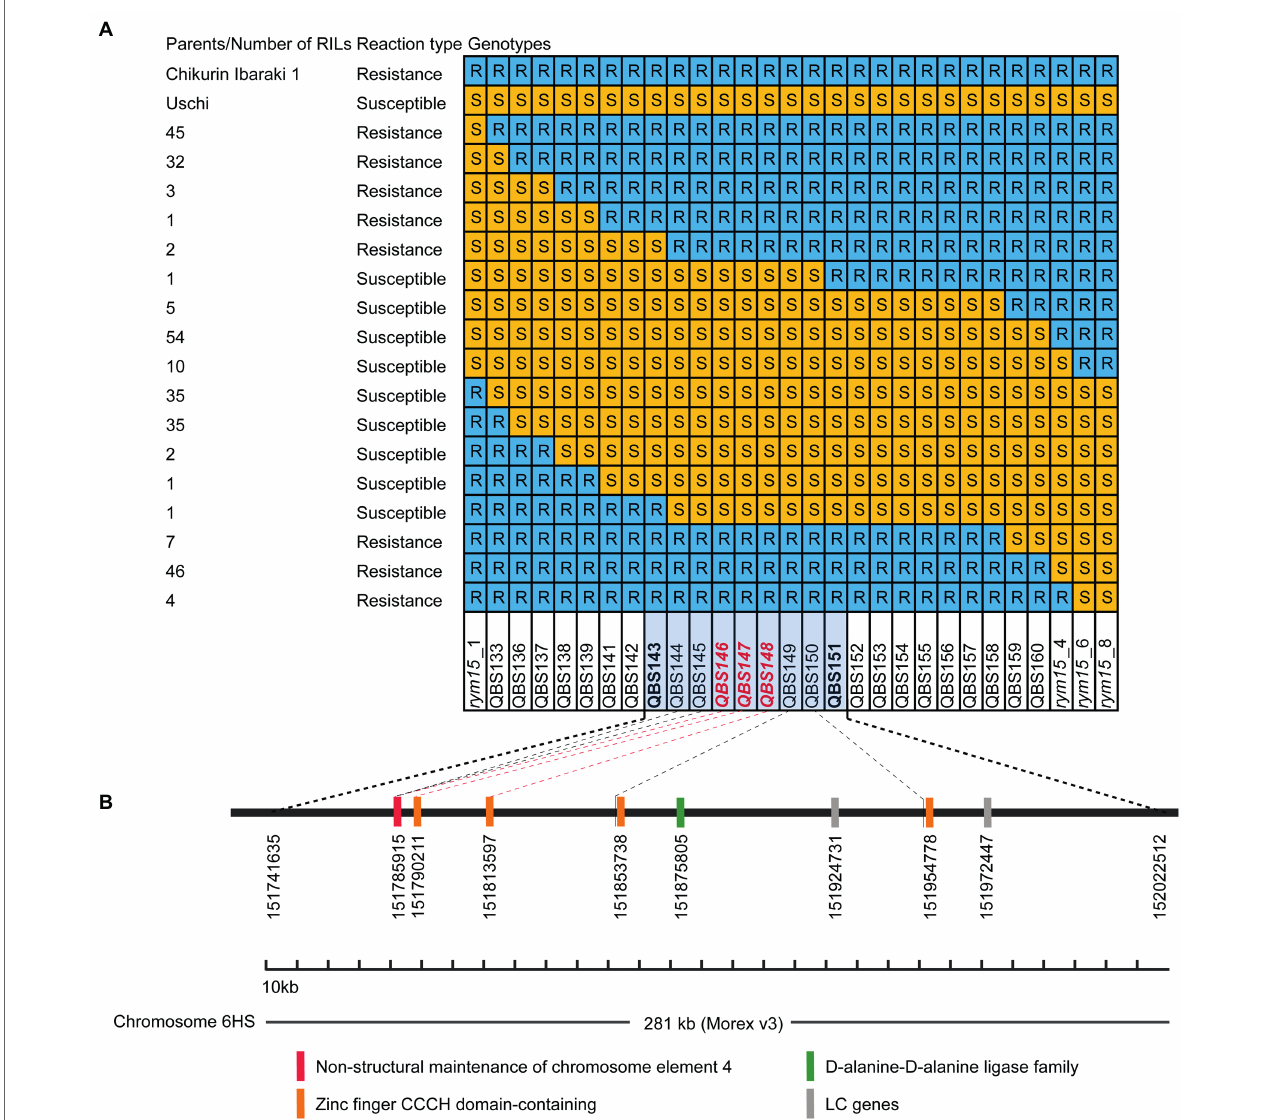
FIGURE 3 | Candidate genes in the rym15 target region of 281 kb. (A) Graphical genotypes of 284 F 4 RILs derived from population Chikurin Ibaraki 1 × Uschi carrying recombination events between rym15 _1 and rym15 _8. Marked with red color are those located in the coding region of high confidence genes. (B) A set of six high confidence and two low confidence genes positioned in the target interval.